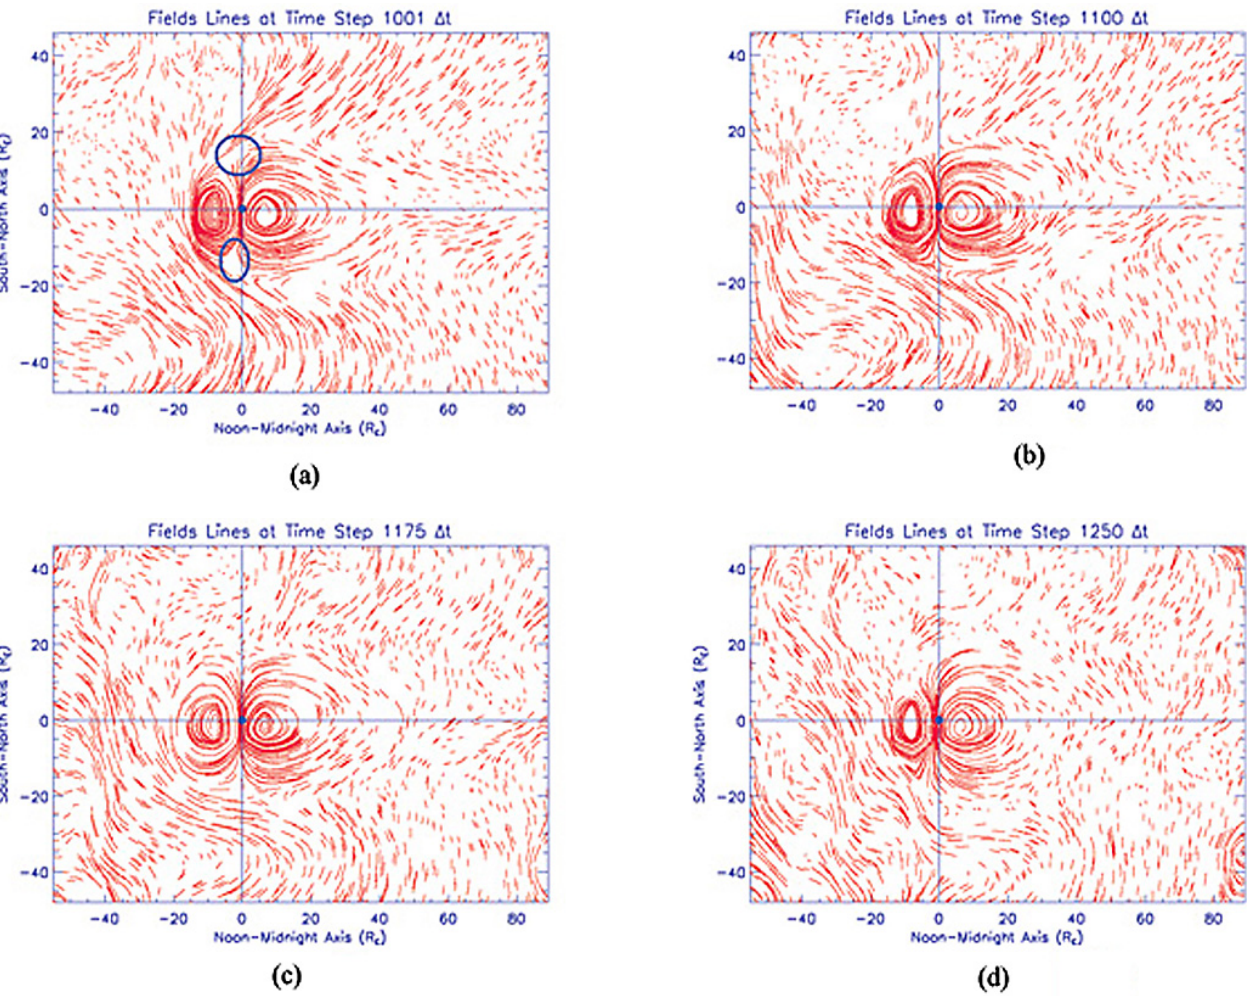
Fig. 4. Time sequence of the response of Earth’s magnetosphere to a depression (abrupt depression effect) in the incident SW flow for B z > 0. Field’s lines are shown in panels (a) , (b) , (c) and (d) , taken at 1001, 1100, 1175 and 1250 1t , respectively. All plots are shown in the x-z plane and centered on Earth’s position at [0, 0, 0] R E corresponding to [60, 52, 53] R E in the simulation box. A zoom of the encircled areas (panel a ) will be shown in Fig. 3 to highlight the reconnection between the geomagnetic and magnetosheath